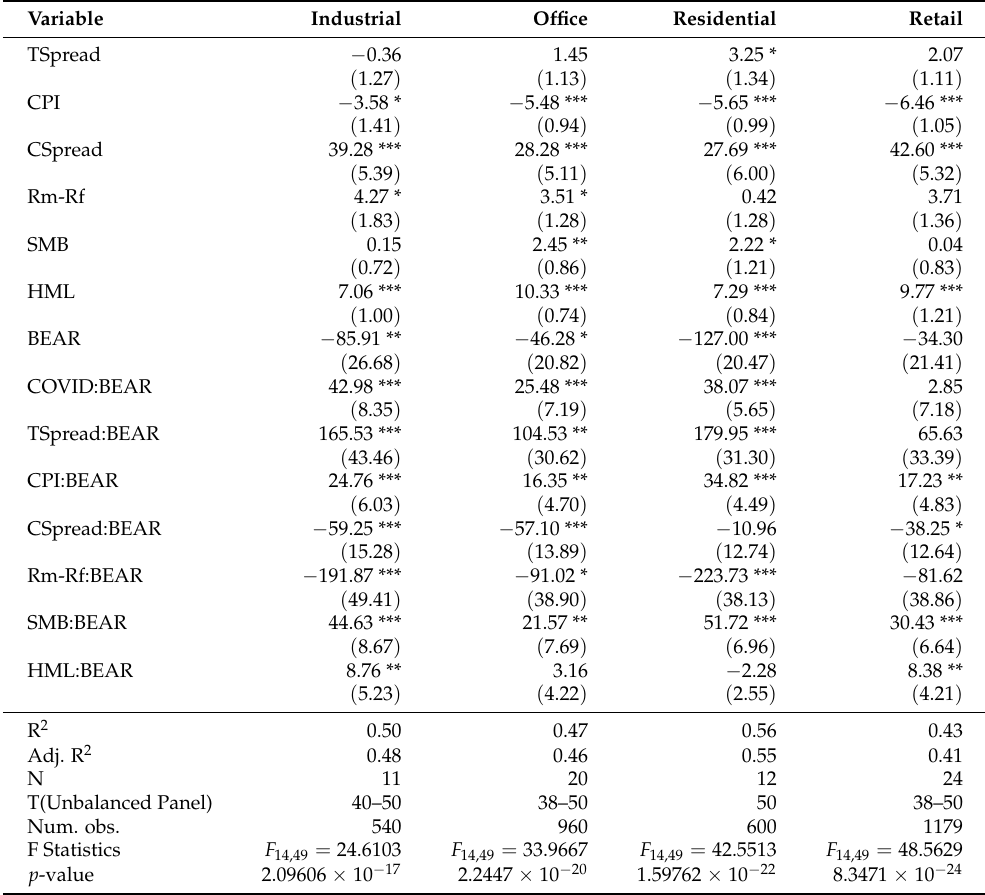
Table A6. Model Result—Specification